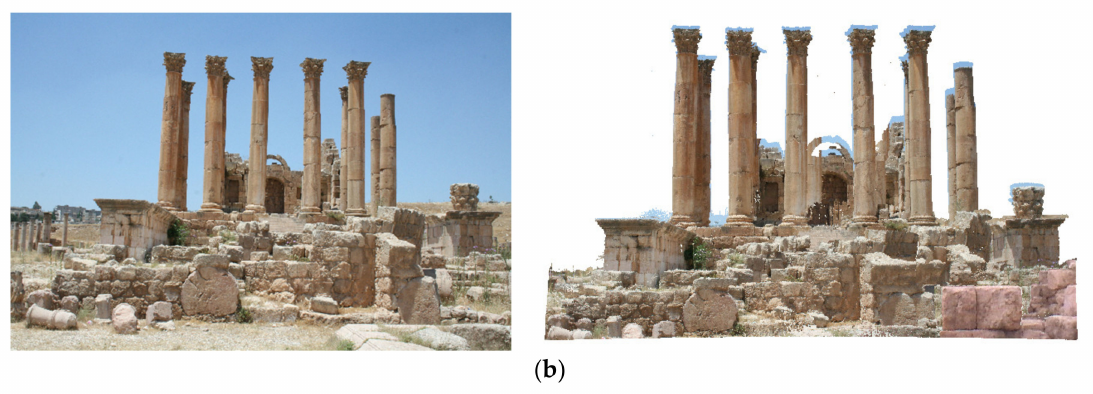
Figure 10. Point cloud coloring of the Artemis façade: ( a ) using a scanner camera; ( b ) using an independent image taken close to the view of the scanner.